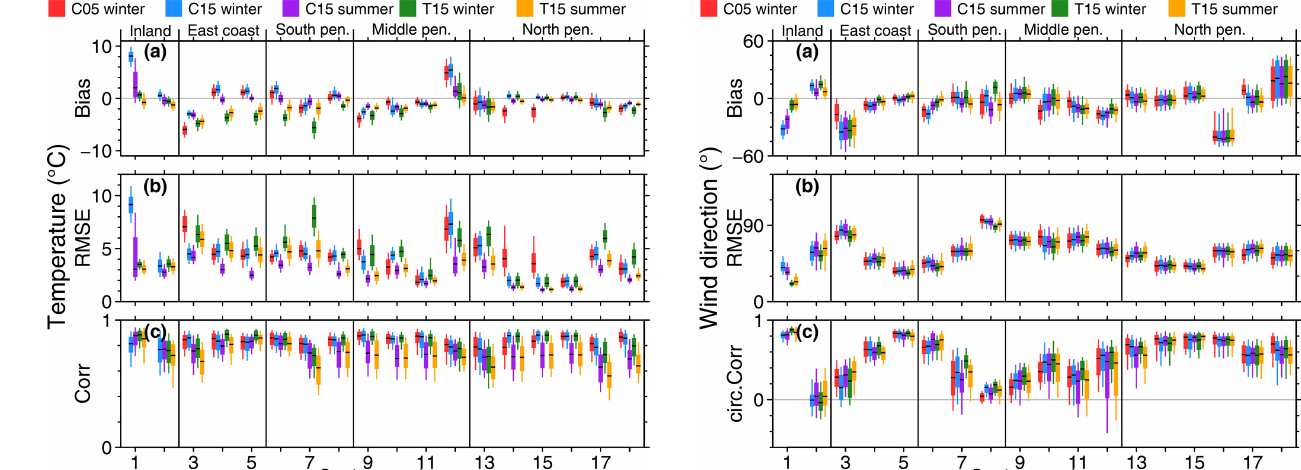
direction for Amundsen–Scott (no. 1) is a result of better rep- resentation of the stable boundary layer in T15. This yields colder surface temperatures that allow for a stronger wind shear and thus a reduced wind direction bias. At AWS Union (no. 2) wind direction is almost constant with time, which results in a low correlation although the bias and RMSE are comparable to other stations. For AWS Fossil (no. 8) there are two dominant wind directions both measured and simulated, but they do not always coincide in time, and thus the RMSE is also very high.